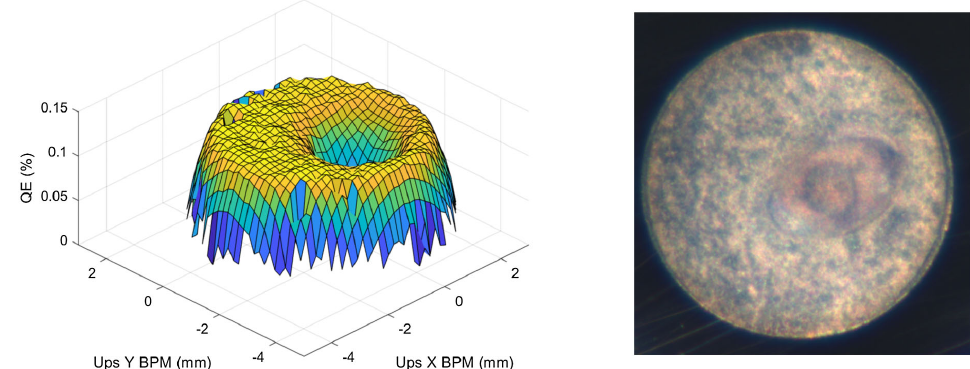
FIG. 11. Left: QE map of the first Cs 2 Te photocathode after 500 h of operation as measured by recording the bunch charge versus downstream beam position as the UV laser was scanned over the cathode surface. Right: photo of the 5-mm-diameter photocathode after it was removed and exposed to